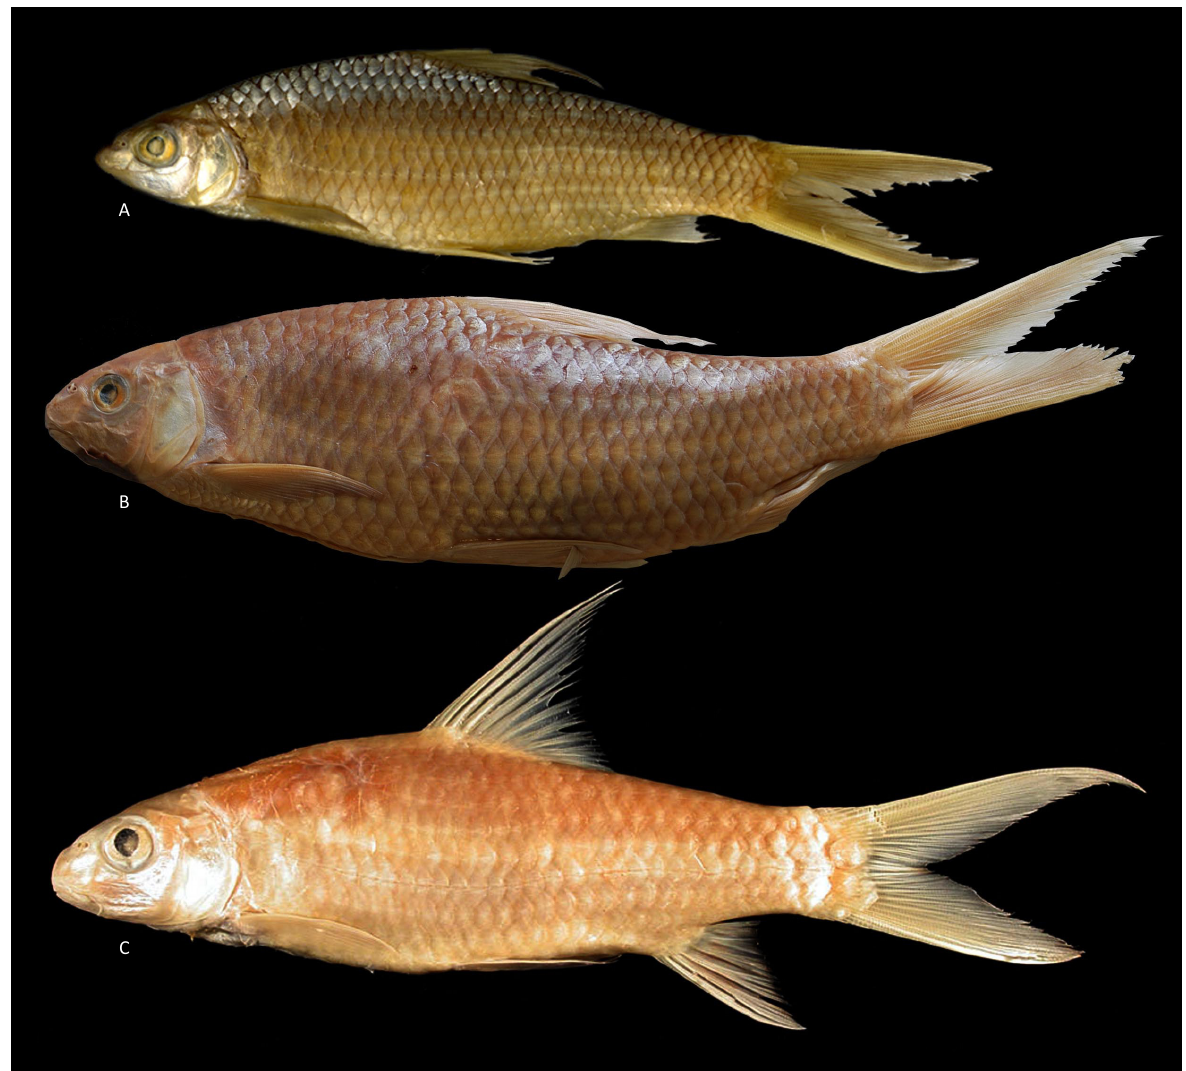
last simple ray weak. Dorsal-fin origin slightly behind pelvic-fin origin, inserted midway between tip of snout and base of caudal fin. Pelvic fin with one simple and 8(1)–9(2) branched rays. Anal fin with three simples and 5½ branched rays. Pectoral fin with one simple and 15 branched rays. Pectoral and pelvic fins short, not reaching pelvic and anal-fin origins respectively. Caudal fin with 19 (1+9+8+1) rays, deeply forked with the principal rays white in colour. Lateral line complete, with 37(1) - 38(2) scales + 1 scale on the caudal fin base. Transverse scales from dorsal-fin origin to ventral fin origin ½ 6/1/ 3 ½ (1) - ½ 6/1/4 (2). Predorsal scales 13(1), 14(2), prepelvic scales 12; and 15 circumpeduncular scales. Pelvic axillary scale present. Gill rakers 5 (1), 6